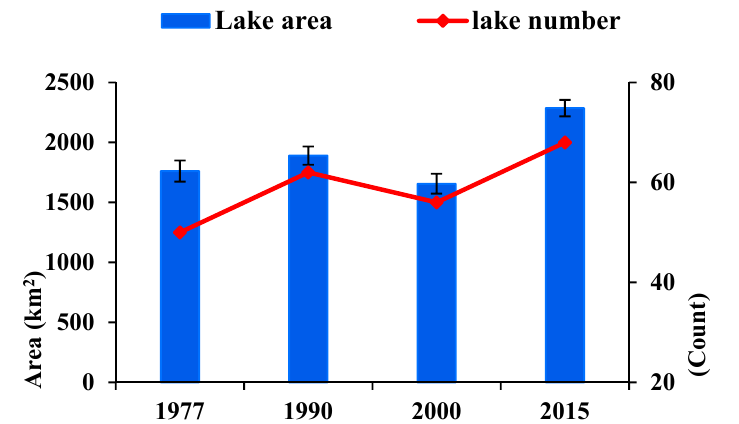
Figure 4. Changes in lake area and number in the four stages between 1977 and 2015. The error bars represent the confidence level of 95%.